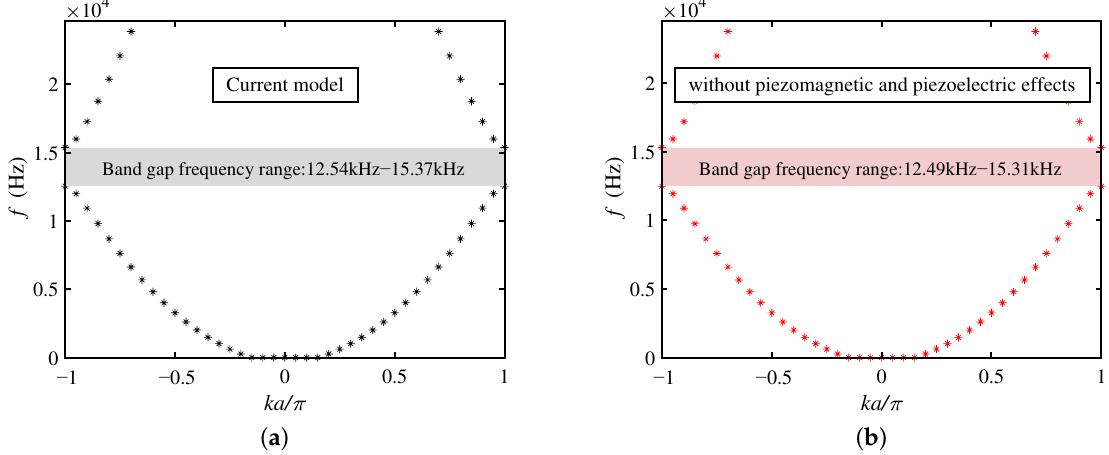
Figure 3. Bandgaps of the current model ( a ) with and ( b ) without piezomagnetic and piezoelectric